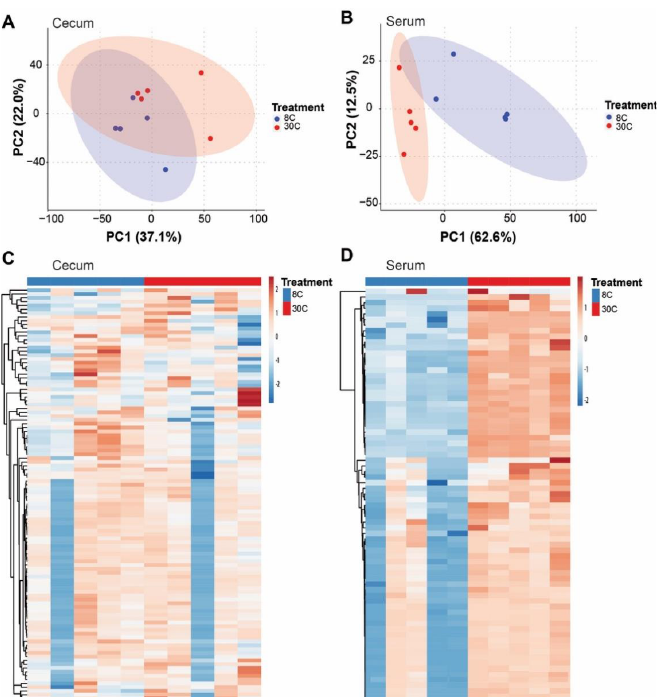
Figure 7. Metabolome profiles of the cecum and serum in mice exposed to different temperatures. Principal coordinate analysis plot based on Bray − Curtis dissimilarities including all metabolite features and showing clustering by temperature in the ( A ) cecum (n = 5) and ( B ) serum (n = 5). Ellipses define the 95% confidence level. Heatmaps from identified metabolite features in the ( C ) cecum and ( D ) serum.